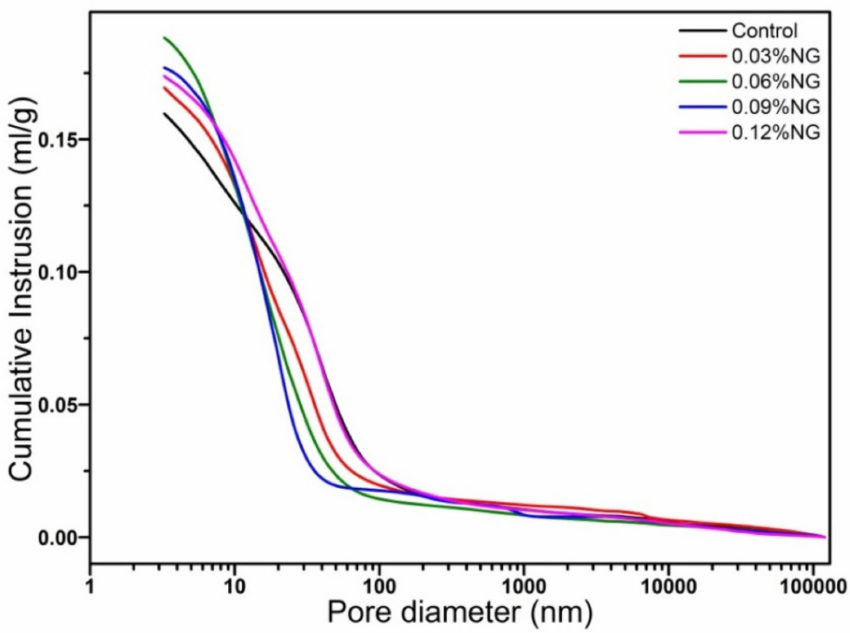
Figure 6. Effect of GO on pore volume of